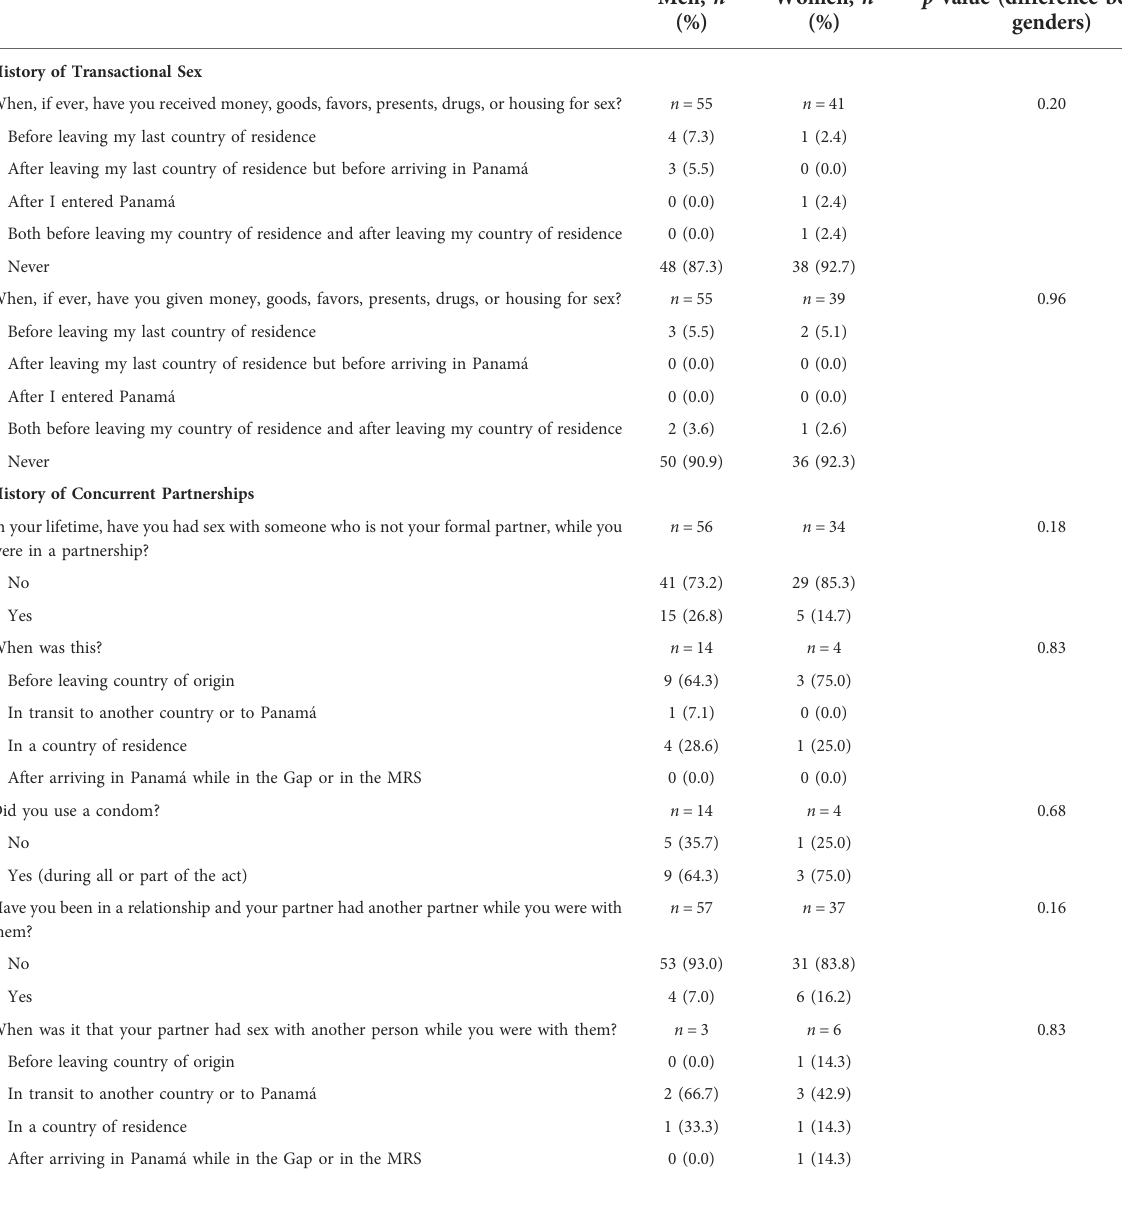
TABLE 3 Transactional Sex and concurrent partnerships (self-reported by adults age ≥ 18